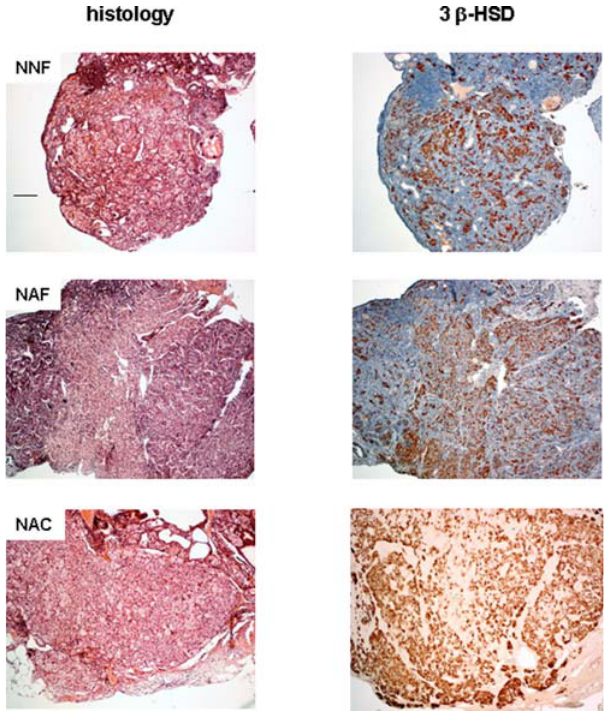
Figure 6. Representative histological and immunohistochem- ical analysis for 3 b -HSD of ovaries at one year after grafting. Mice were grafted with fresh (NNF, NAF ) or cryopreserved (NAC) immature cortex ovaries. Recipients were non-mature (NNF) or adult mice (NAF and NAC). Scales bar 100 m m.